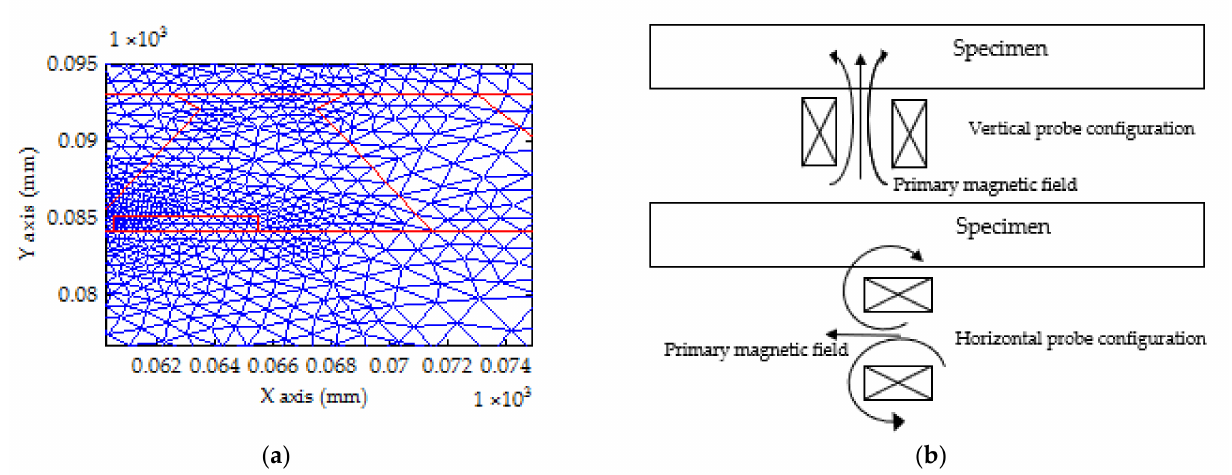
Figure 8. ( a ) Finite element mesh; ( b ) Excitation probe configurations.